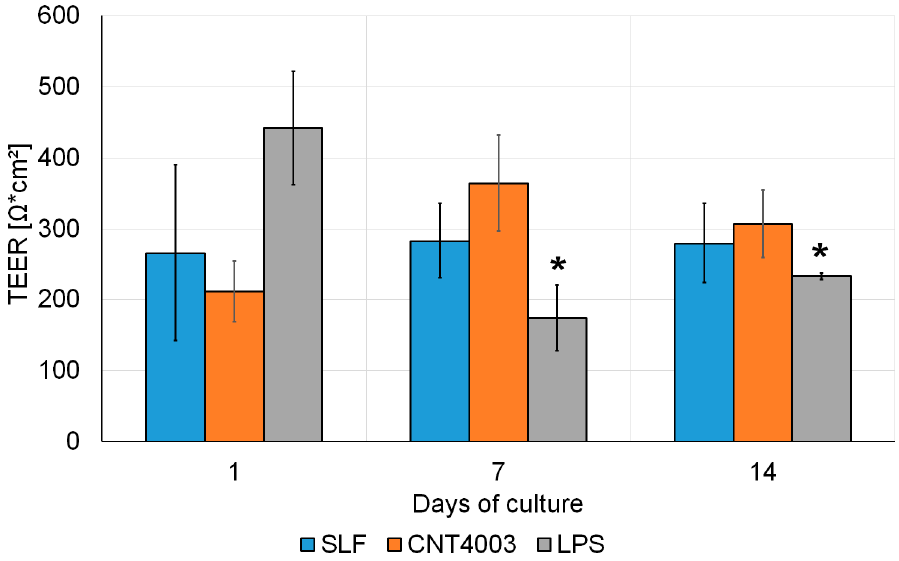
Figure 4. Time-dependent changes of transepithelial electrical resistance (TEER) in EpiAirway™ tissues exposed to simulated lung fluid (SLF) alone or SLF containing CNT4003. Significant decreases compared to 1d are indicated by an